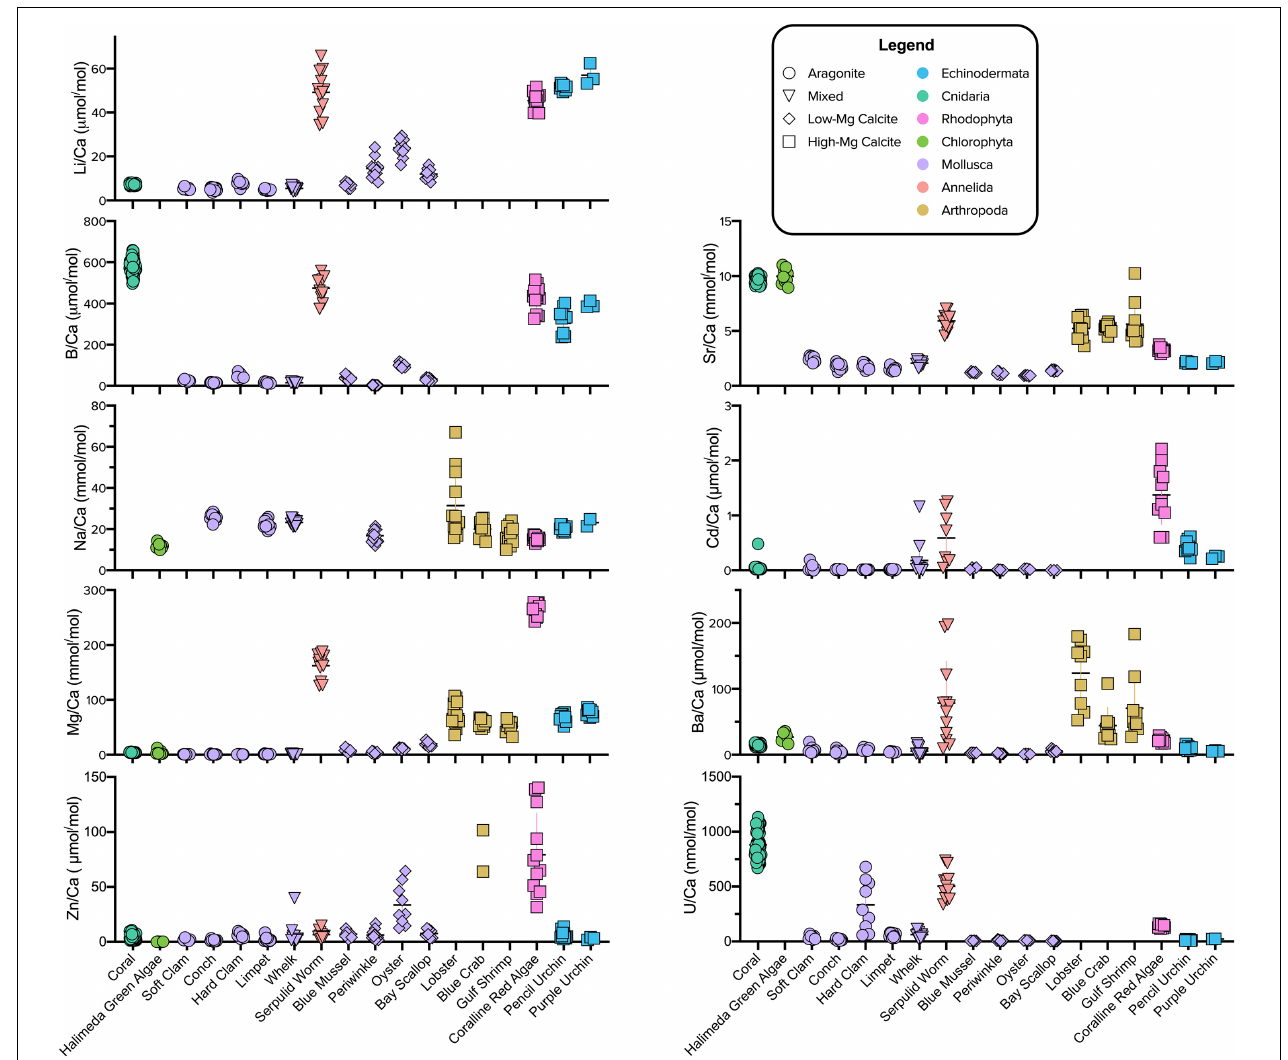
FIGURE 1 | Elemental ratio data across all p CO2 culture conditions combined for the invertebrates studied. Color and shape indicate phylum and mineralogy, respectively. The species are organized from left to right according to mineralogy: Aragonite, Mixed Mineralogy, and Calcite. Mixed Mineralogy refers to carbonates with less than 90% of either aragonite or calcite. Differences between species and phyla are typically much greater than the variation within species data that could be attributed to varying seawater conditions. Note some elemental ratios are not displayed to avoid scale compression or due to low confidence in their analytical accuracy (e.g., arthropod Zn/Ca; see section “Materials and